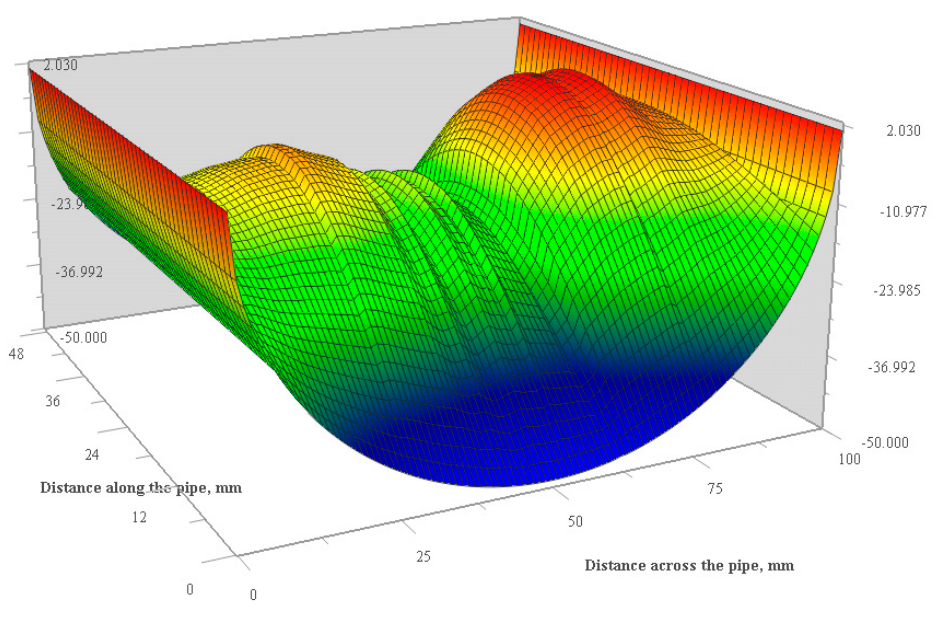
Figure 2. 3D visualization of a random surface pattern.